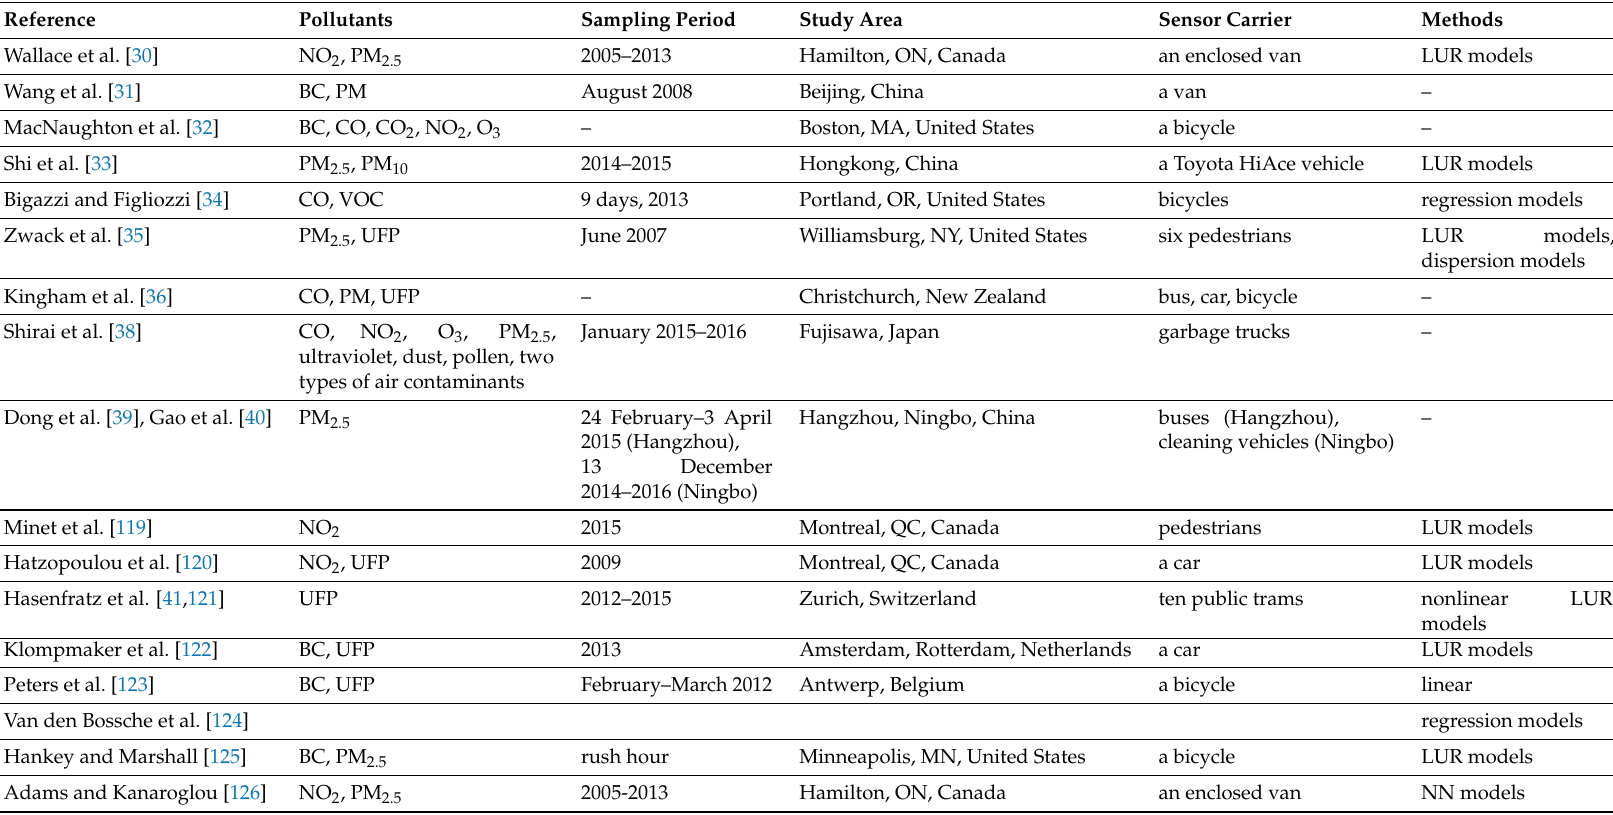
Table 3. Studies on mobile air pollution